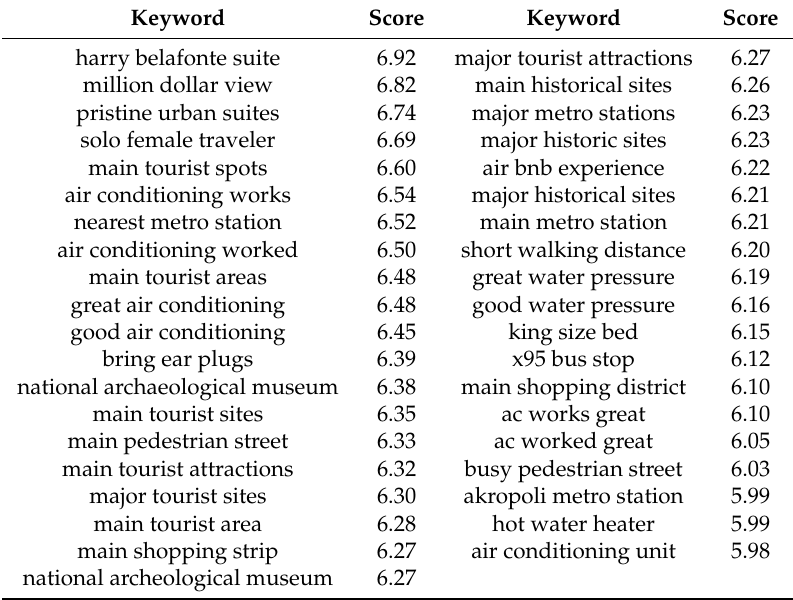
Table 4. Most popular keywords extracted via RAKE from reviews of Emporiko Trigono-Plaka Airbnb